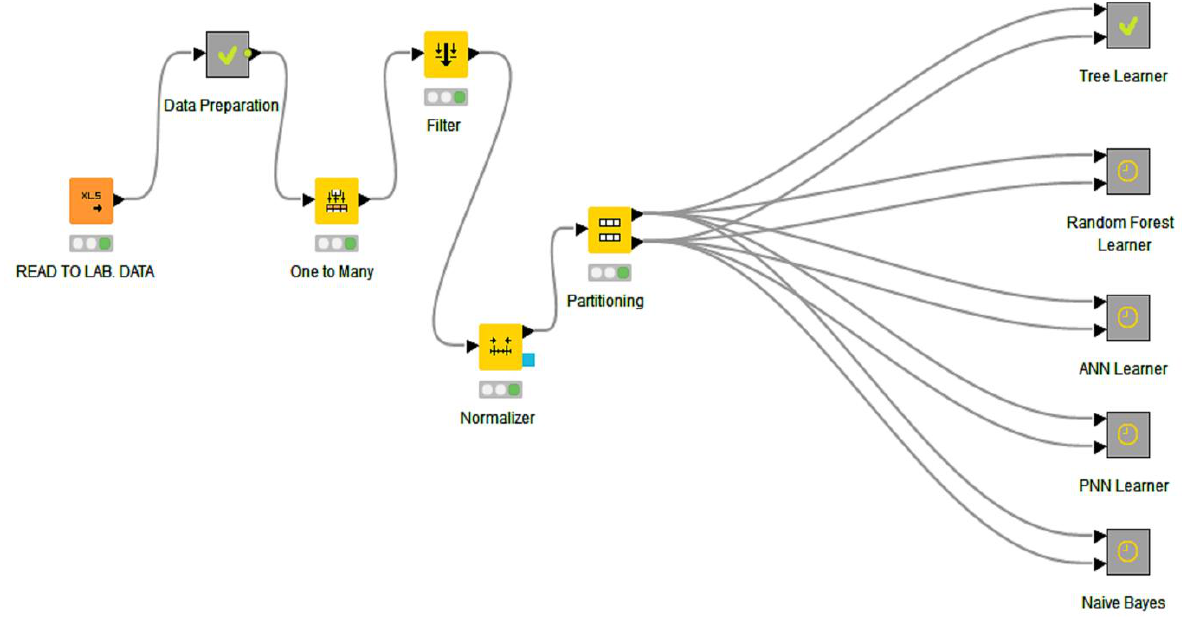
Figure 2. Knime workflow for generating predictions and calculate